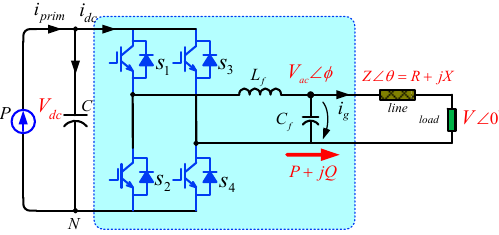
Figure 2. Microgrid architecture for one distributed generation (DG).